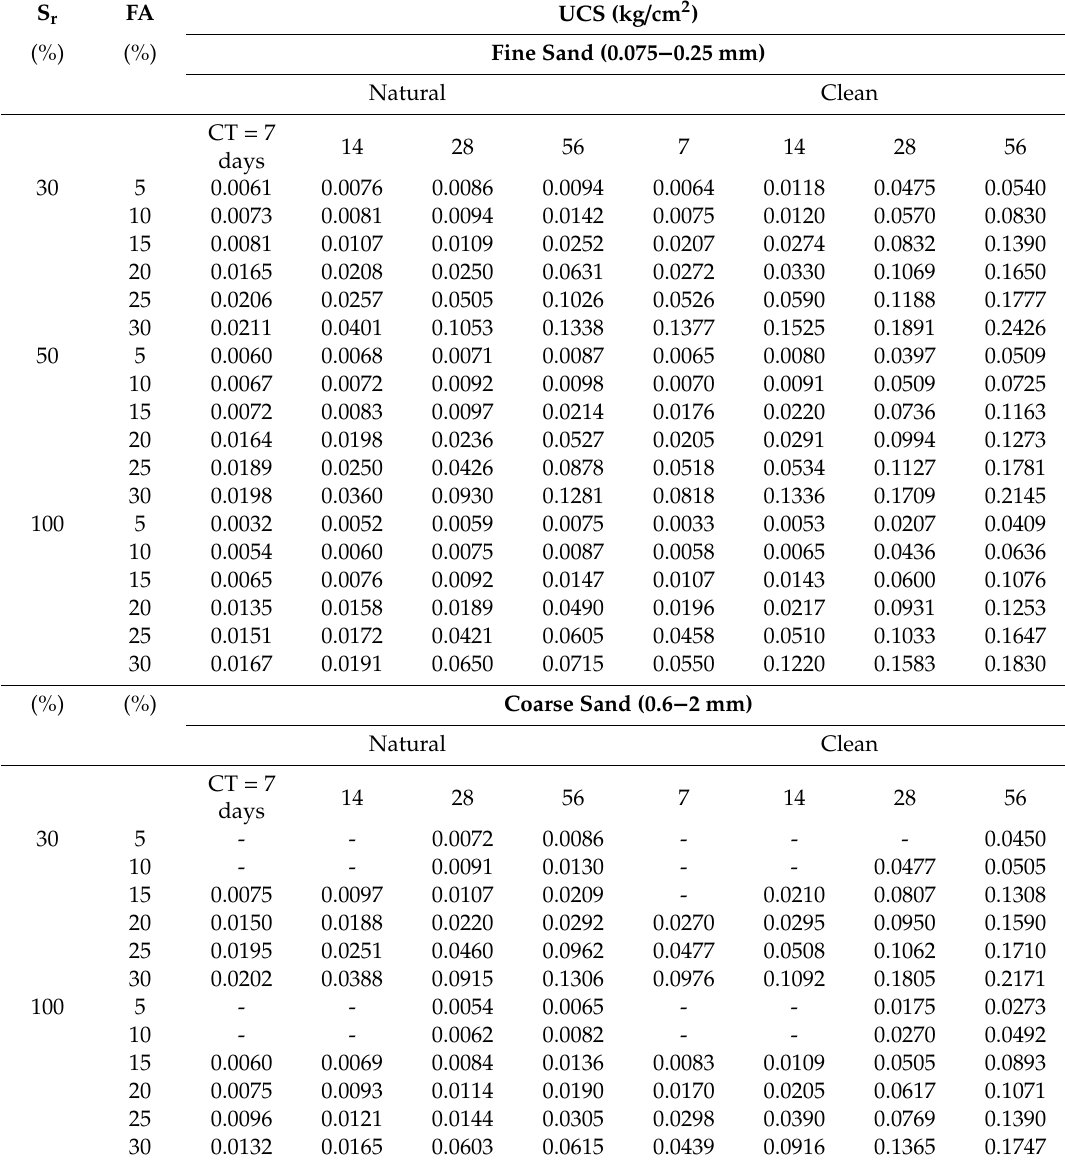
Table 5. Unconfined compressive strength (UCS) of sand stabilized with fly